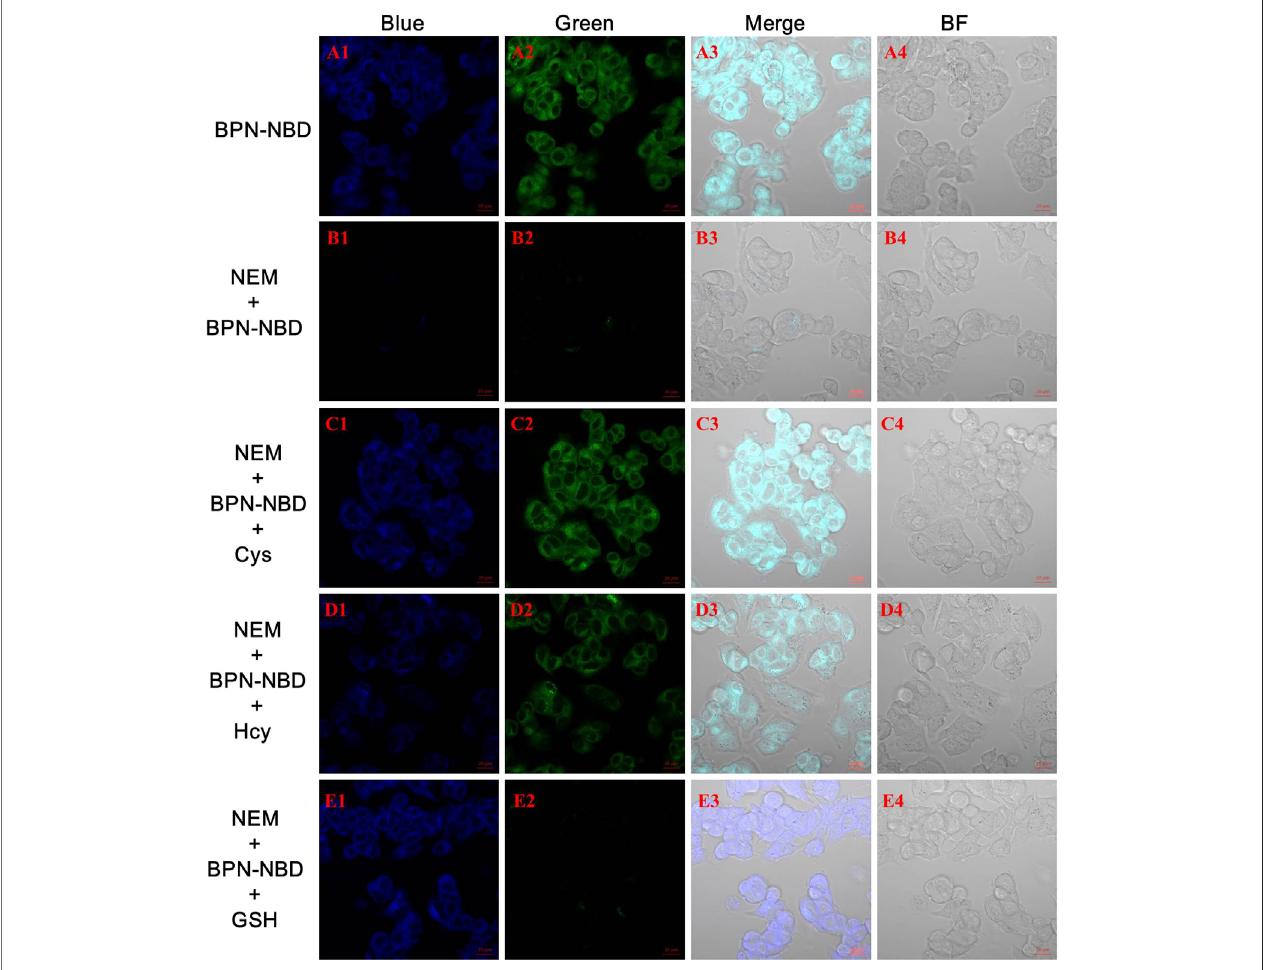
FIGURE 4 | The Bright- fi eld and fl uorescence confocal imaging of biothiols in MCF-7 cells with BPN-NBD. (A) MCF-7 cells stained only with BPN-NBD (10.0 µM) for30 min (B) NEM-MCF-7-cellsincubated withBPN-NBD (10.0 µM)for30 min (C – E) ThesimilarcultivationsforNEM-MCF-7-cells treatedwiththereplacementofCys (C) /Hcy (D) or GSH (E) (150.0 µM) for 30 min and then incubated with BPN-NBD (10.0 µM) for another 30 min. Emissions were collected at 425 – 475 nm for the blue channel (excitation wavelength: 405 nm) and 515 – 550 nm for the green channel (excitation wavelength: 488 nm). Scale bar: 20